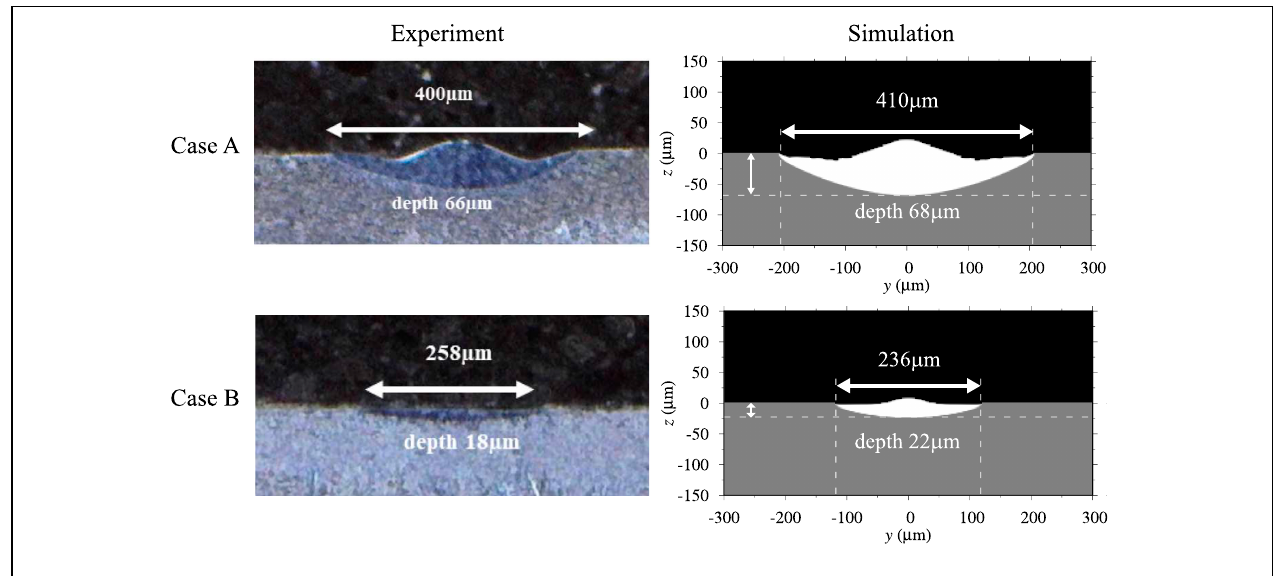
FIGURE 4 | The track cross-sections of the bead-on-plate for case A and case B.